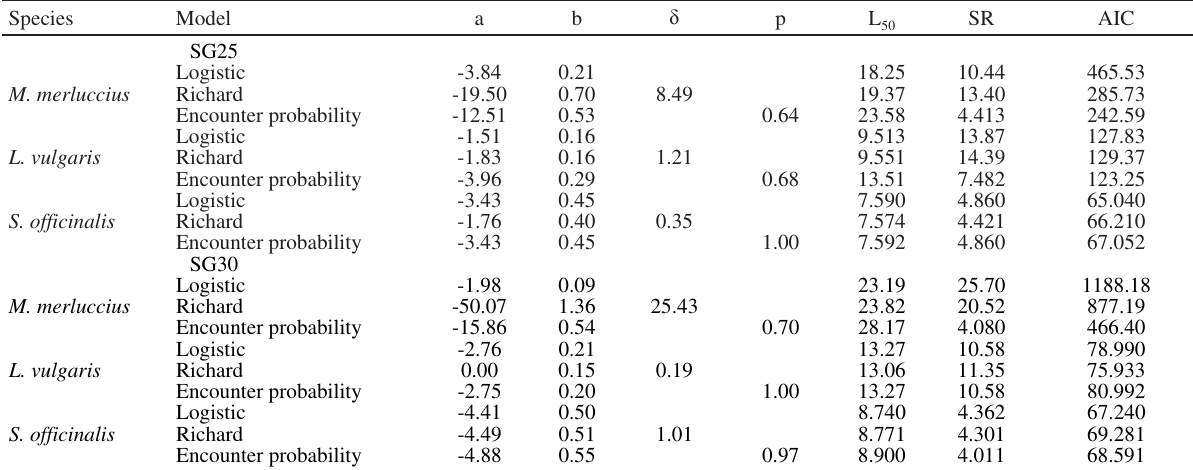
Table 6. – Escape selection curve parameters (a. b. δ and p), length of 50% escapement (L ) in cm for fish species and cuttlefish and mm for 50 N. novergicus , and selection range (SR) for the main commercial species for sorting grids with 25- and 30-mm bar spacing (SG25 and SG30, respectively). AIC, Akaike information criterion.